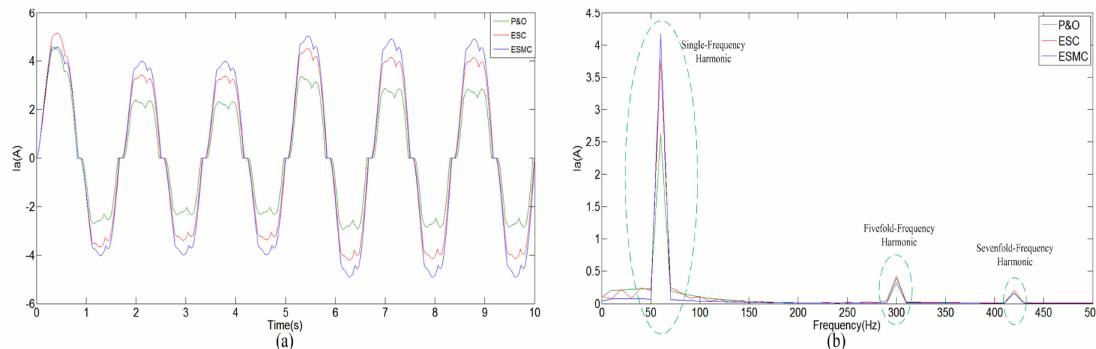
Figure 12. ( a ) Three control methods and the generator input current i a ; and ( b ) fast Fourier transform (FFT) spectrum analysis of the generator input currents i a of the three control methods.